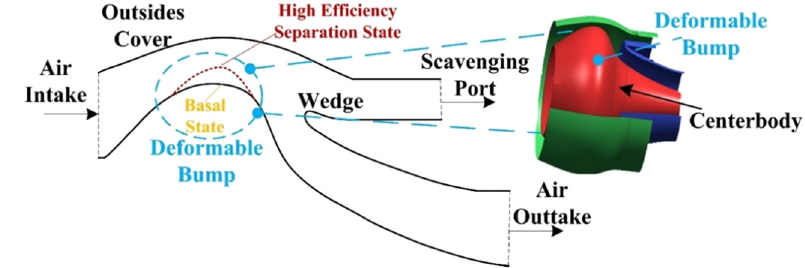
Figure 1: Structure of multi - condition deformable particle